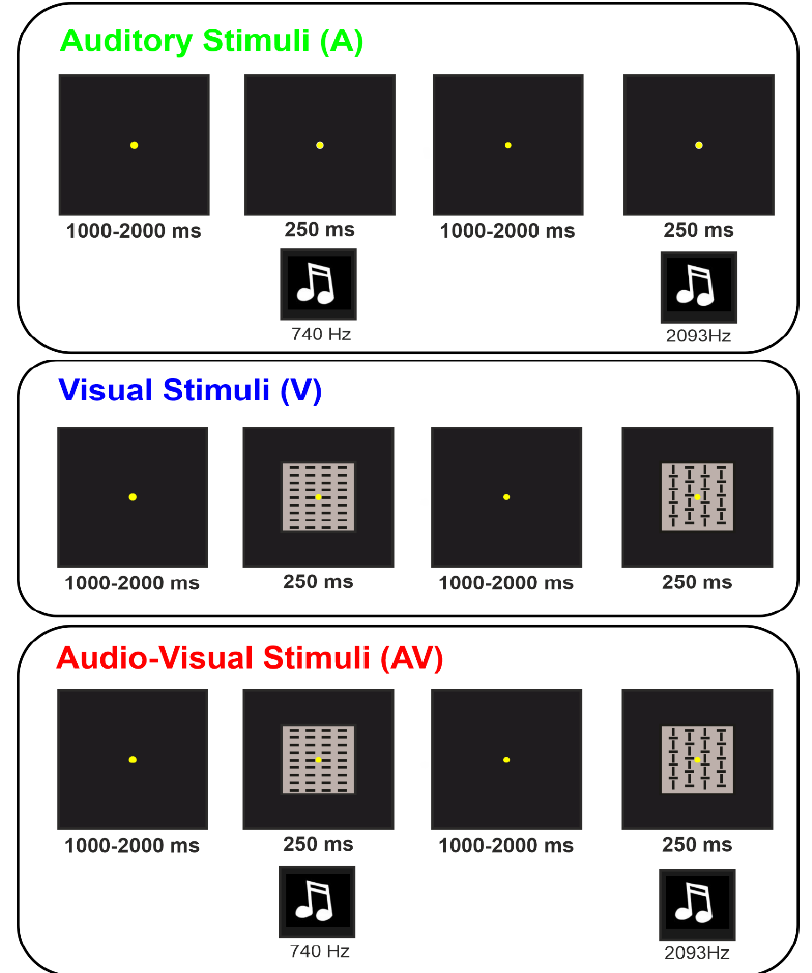
Figure 1. Schematic representation of the stimuli adopted in the three conditions for the Auditory (A), Visual (V) and Audio-Visual (AV) modalities. In the AV condition, auditory and visual stimuli were presented simultaneously. Two examples of the combination between stimuli in the AV condition are displayed in the Figure.